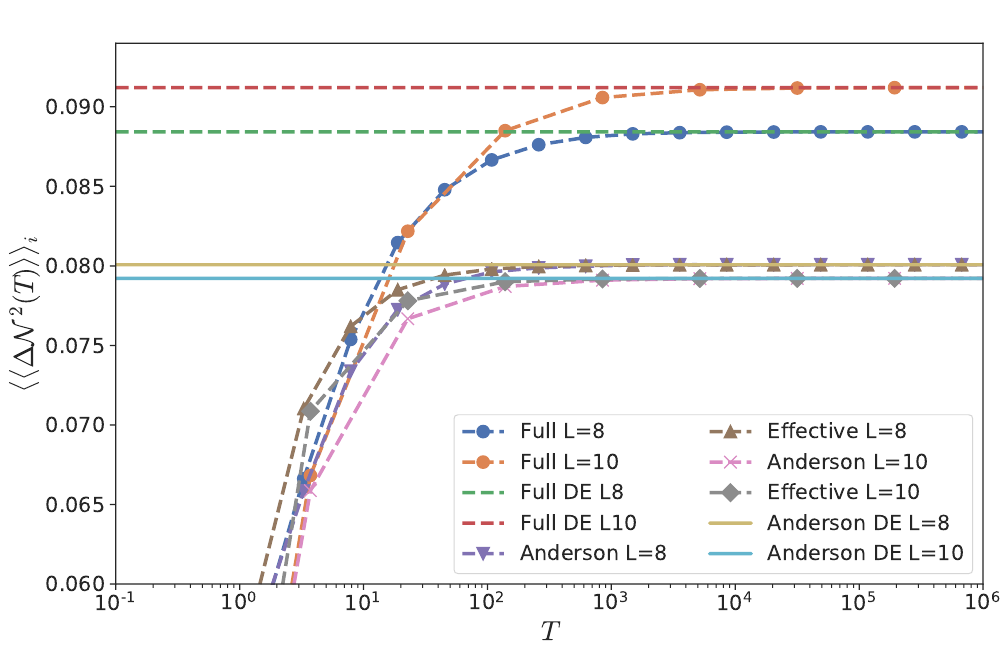
Figure 7: Particle fluctuations in a partition averaged over all intial states (cid:82) T (cid:10)(cid:10) ∆ (cid:11)(cid:11) (cid:10)(cid:10) ∆ (cid:11)(cid:11) = 1 N 2 ( t ) N 2 ( T ) dt for the interacting spinless fermion model T i i 0 with disorder compared to those in the Anderson and the effective model. 10000 disorder realizations are used for L = 8, and 5000 for L = 10.